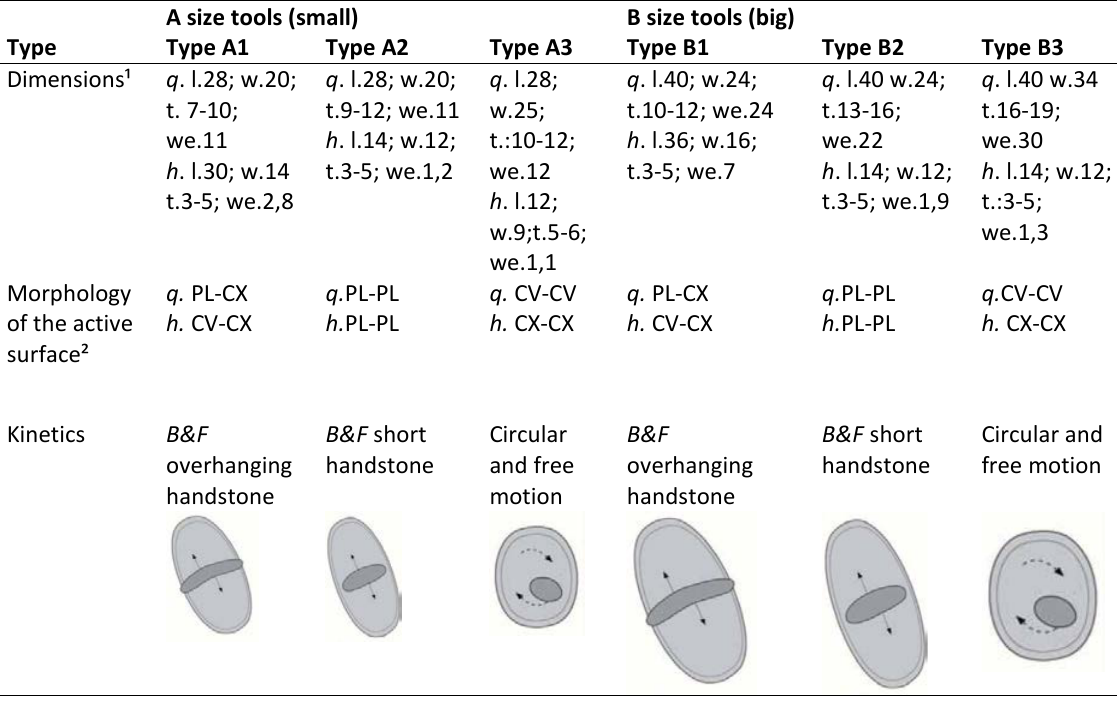
Table 1. Size, morphology and kinetics of PlantCult experimental grinding stone tool types. q = quern; h =handstone; B&F = Back and forth motion. Dimensions 1 are given in cm for length (l.), width (w.) and thickness (t.), and in kg for weight (we.). Morphologies 2 of the active surfaces are given as long axis section – cross section